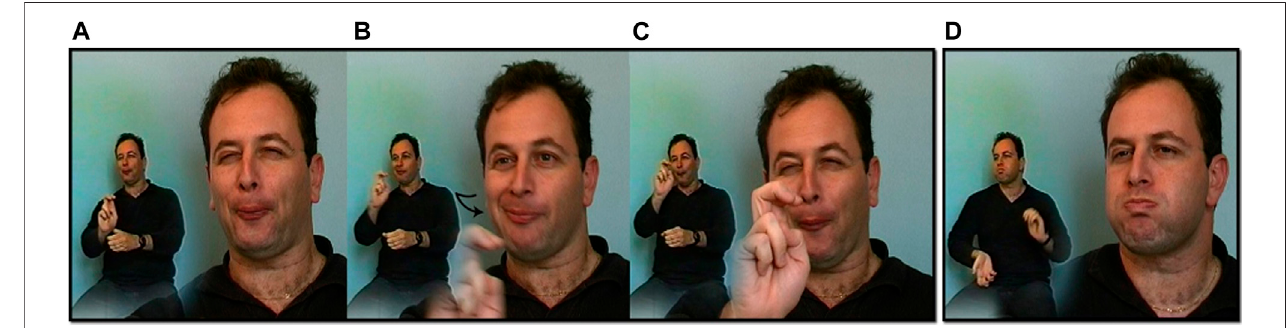
FIGURE8| MouthgesturesinISLretellingofCanaryRowcartoon. (A) Pursedmouth andsuckedcheeksforatight fi tinanarrowspaceandclimbingupinsidethe space (cat entering the drainpipe); (B) zig-zag mouth movement for the zig-zag crook in the drainpipe; (C) the cat making its way up inside the drainpipe; (D) puffed cheeks for the full round shape of the bowling ball (from Sandler,